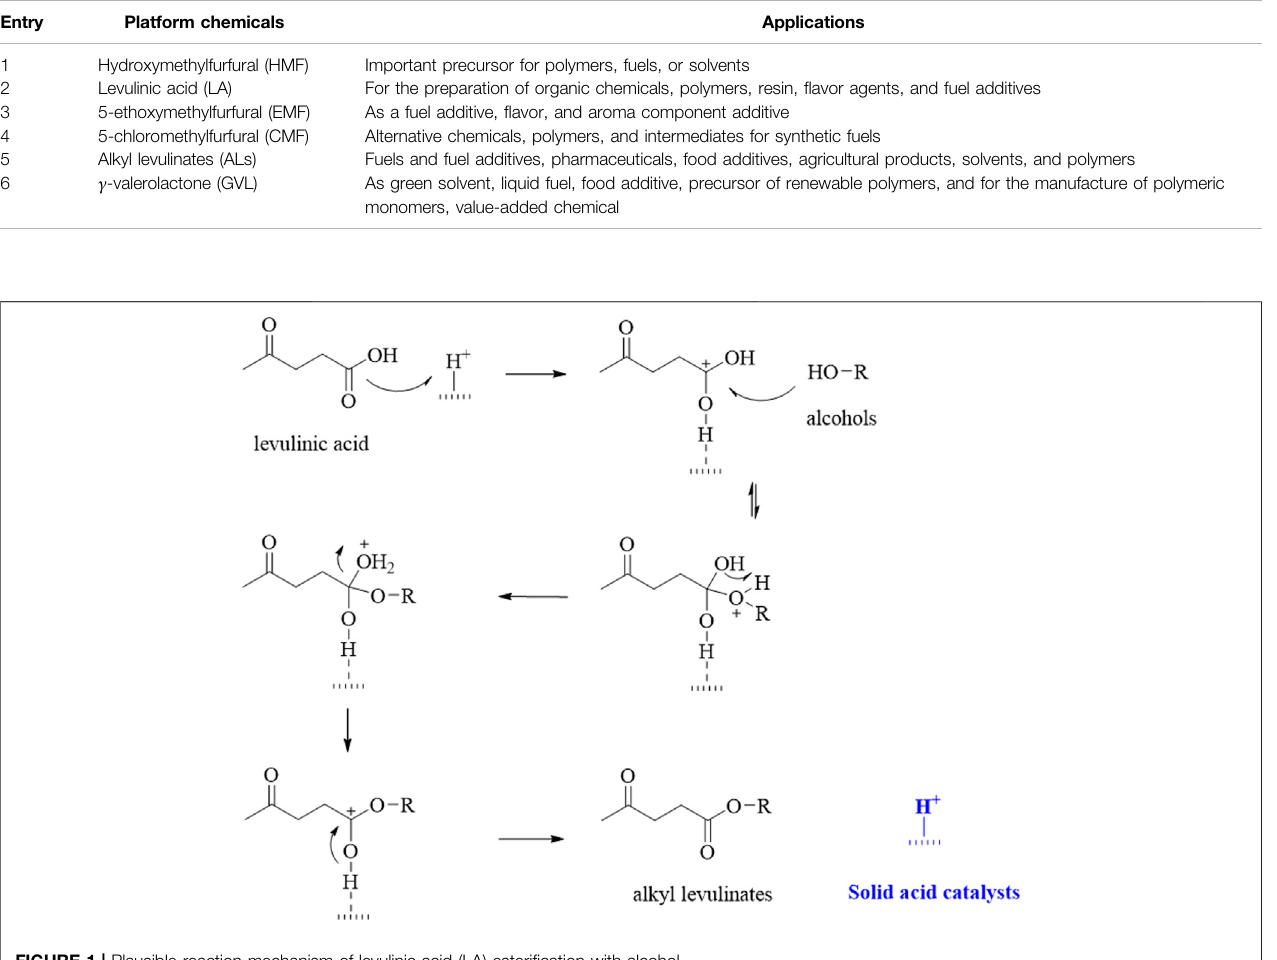
Frontiers in Chemistry |